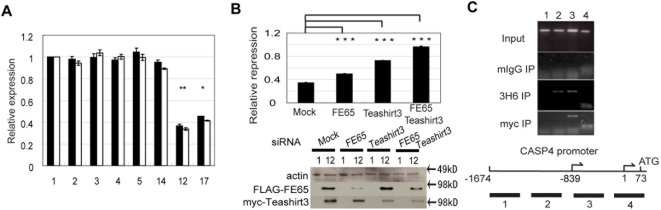
Regulation of caspase-4 expression in H4 cells by Teashirt3 and FE65.
A, Expression of caspase-4 in stable cell lines. Extracts from indicated cell lines were subjected to qPCR followed by normalization of caspase-4 expression to that of control genes using qBase (version 1.3.5). Three independent experiments were then each normalized to the expression levels of clone 1 (far left) and means and SEM determined. Two distinct probes [identified here as caspase4 (black bars) and caspase4 (white bars)] were used for caspase-4 gene expression. Significant differences in expression were observed for both probes when comparing clones expressing both Teashirt3 and FE65 (clones 12 and 17), as compared to GFP-expressing clones (clones 1–5 and 14). Statistical analyses were performed using two-way ANOVA (P<0.0005) followed by Dunnett's T3 post-hoc testing. (*, P<0.05; **, P<0.01). B, Effects of siRNA on caspase-4 expression in stable cell lines. H4 cells stably expressing either GFP (clone 1) or FE65 and Teashirt3 (clone 12) were transfected with siRNA against indicated exogenous proteins. Normalized levels of caspase-4 were quantified as in A, and the fold inhibition of caspase-4 (expressed as the ratio of normalized expression in clone 12 to that in clone 1) in each condition determined. Immunoblot analysis is shown out for a representative experiment. Statistical analyses were performed using ANOVA (P<0.001) followed by Bonferroni post-hoc testing. ***, P<0.001. C, Chromatin immunoprecipitation (ChIP) assay with FE65 and Teashirt3. Sonicated chromatin from clone 12 was used for ChIP was subjected to immunoprecipitation with either control mouse IgG, 3H6 anti-FE65, or anti-myc antibodies, and the washed precipitates (as well as an aliquot of the original lysate, indicated as Input) were used for PCR. The scheme below indicates the location of amplified regions in relation to the major transcription start site (1), indicated by an arrow and initiation codon (73) of the CASP4 gene. Another arrow at −839 position indicates an alternative transcriptional start site.